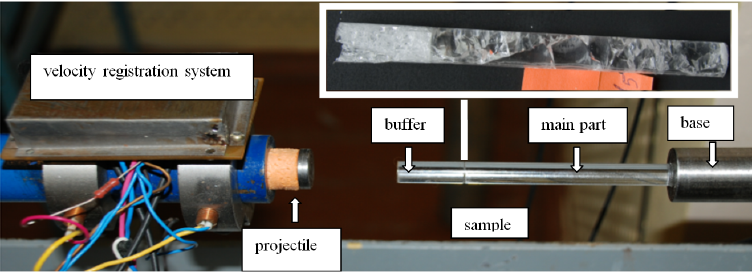
Figure 4: Ballistic set-up. An example of the fragmentation pattern is given in the upper right-hand corner.